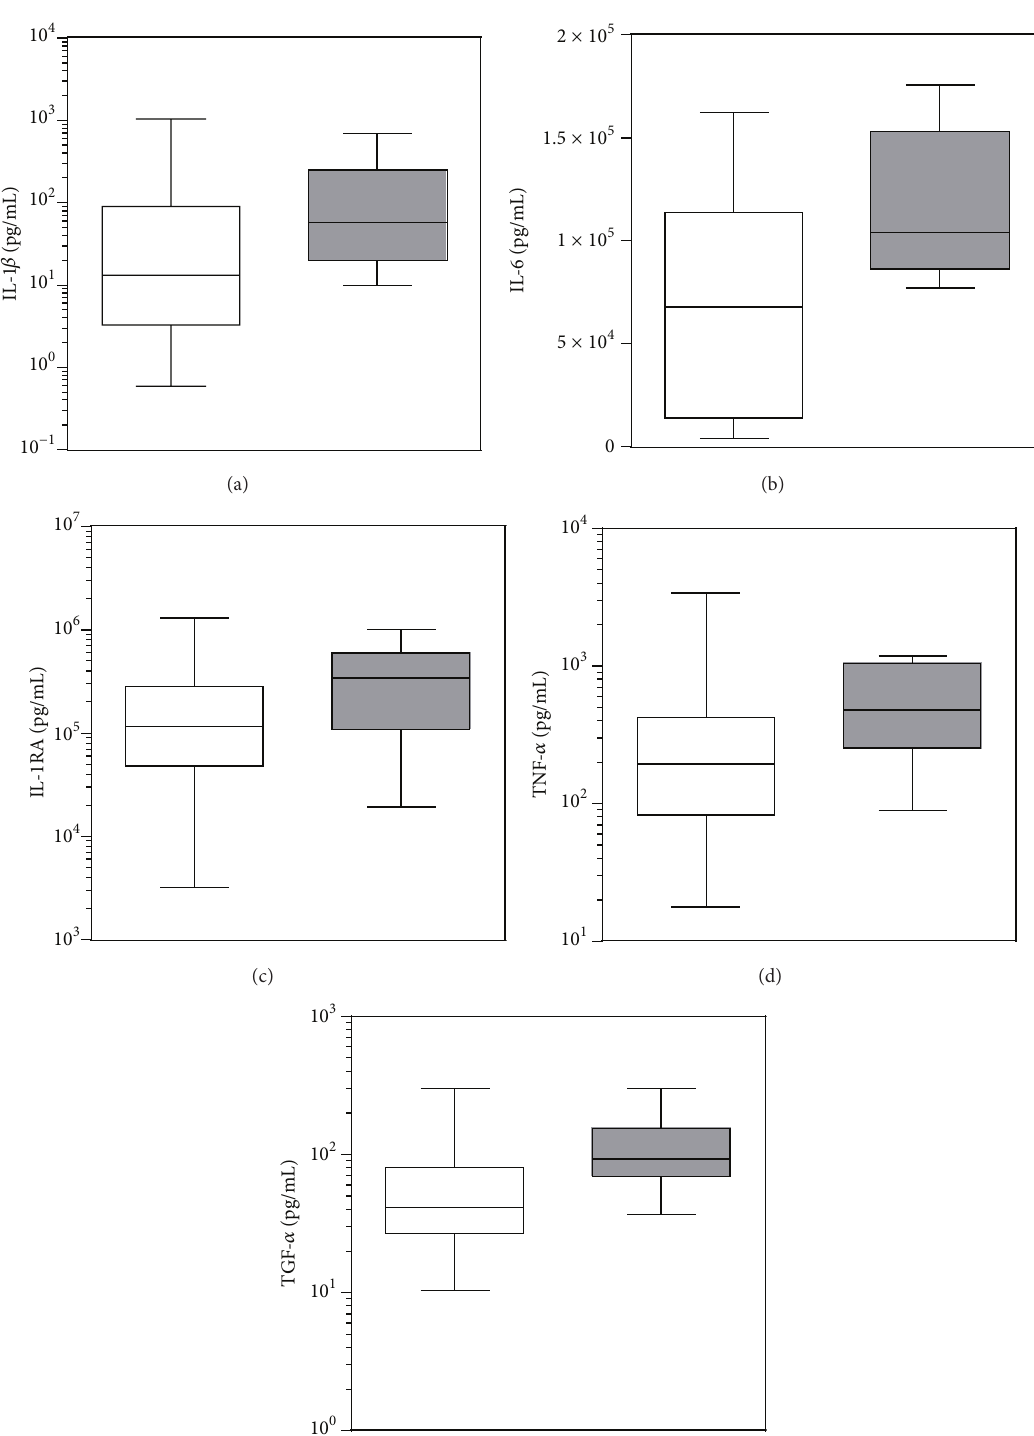
Figure 4: Significant differences in cytokines CSF levels in relation to disease outcome. Patients were grouped independently of the etiological agents based on the outcome (nonlethal, white boxes/lethal, grey boxes) of the disease. Pairwise comparisons (Mann-Whitney test) revealed statistically significant differences for the 5 cytokines (see also Table